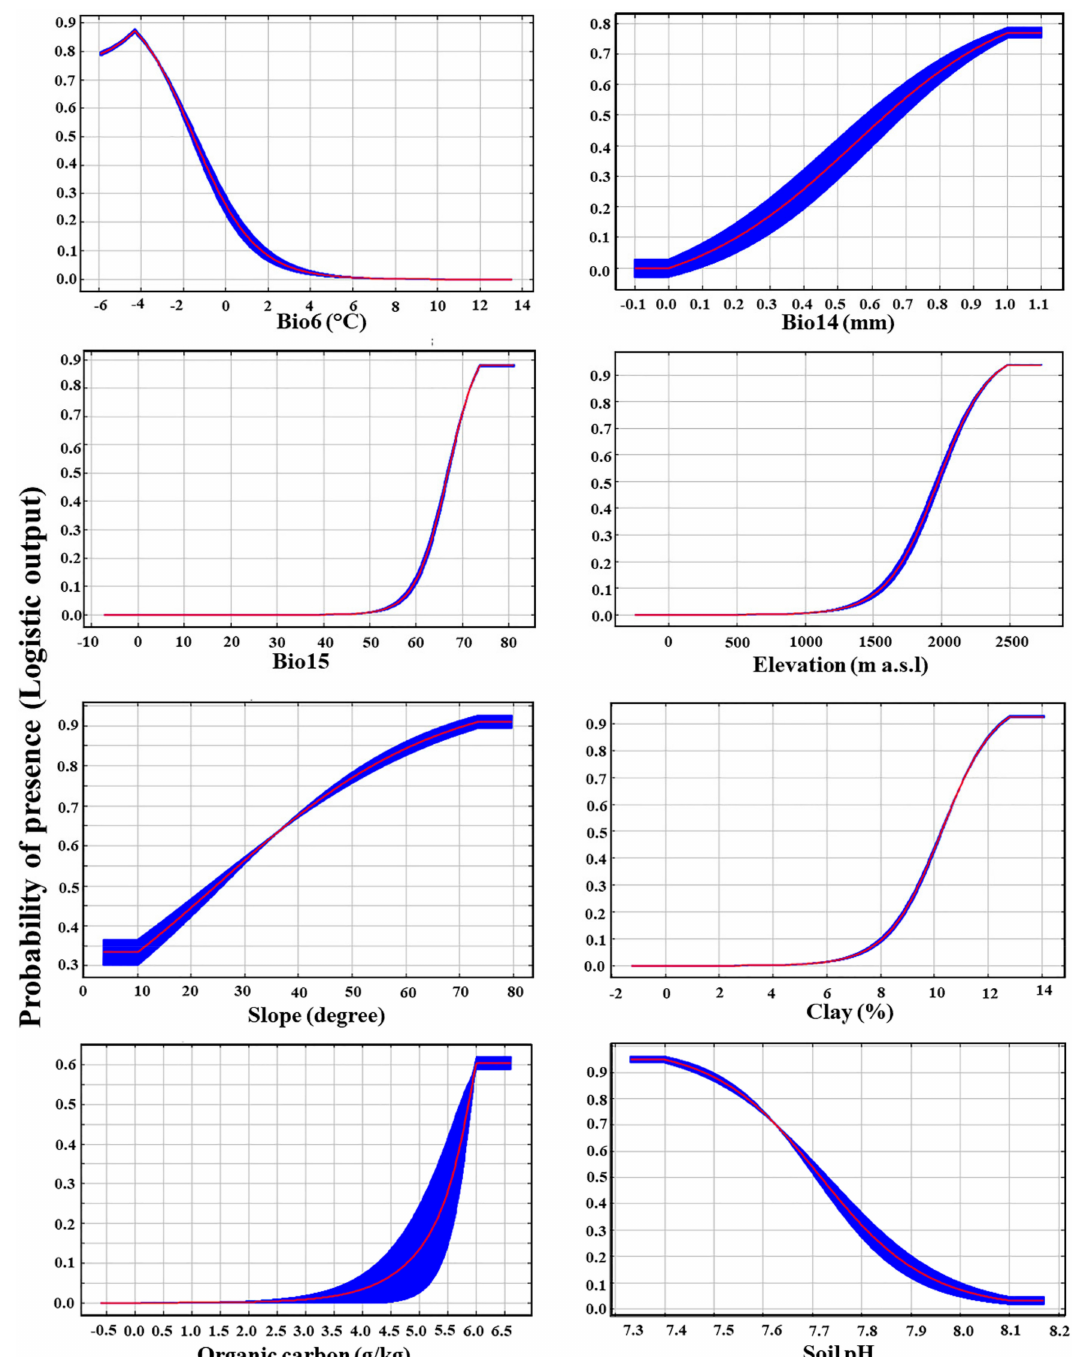
Figure 2. Response curves for the highest contributed predictors in Primula boveana current distribution models. The red curves show the mean response of the 10 replicated runs and the blue shades represent +/ − one standard deviation. Y-axis values are the predicted probability of habitat suitability, as provided by the logistic output